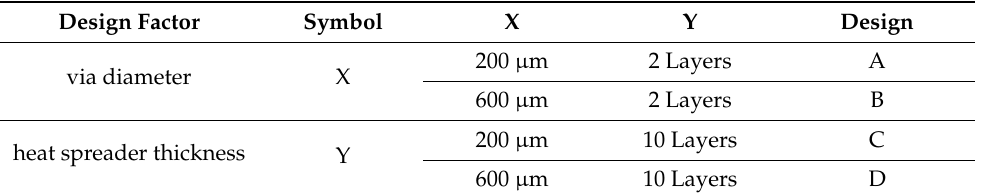
Table 2. Full factorial design and